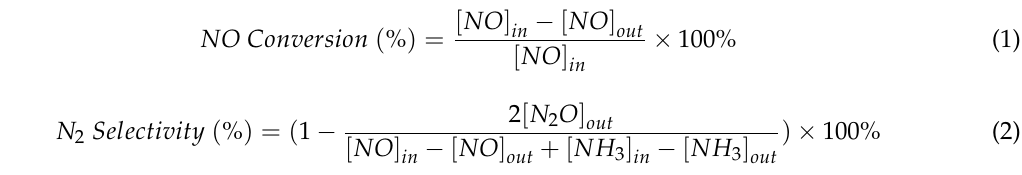
Figure S1. XRD patterns of Fe/W-CeO 2 and CeO 2